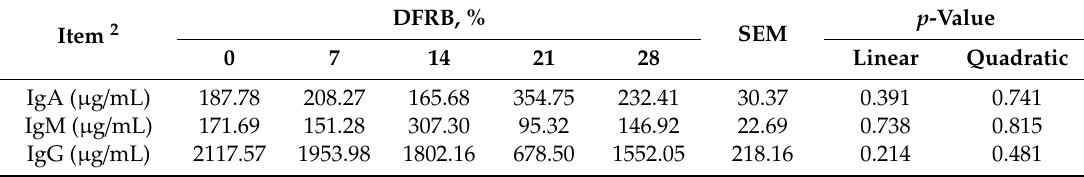
Table 5. E ff ects of increasing DFRB supplementation on serum immunoglobulins of finishing pigs 1 . Item 2